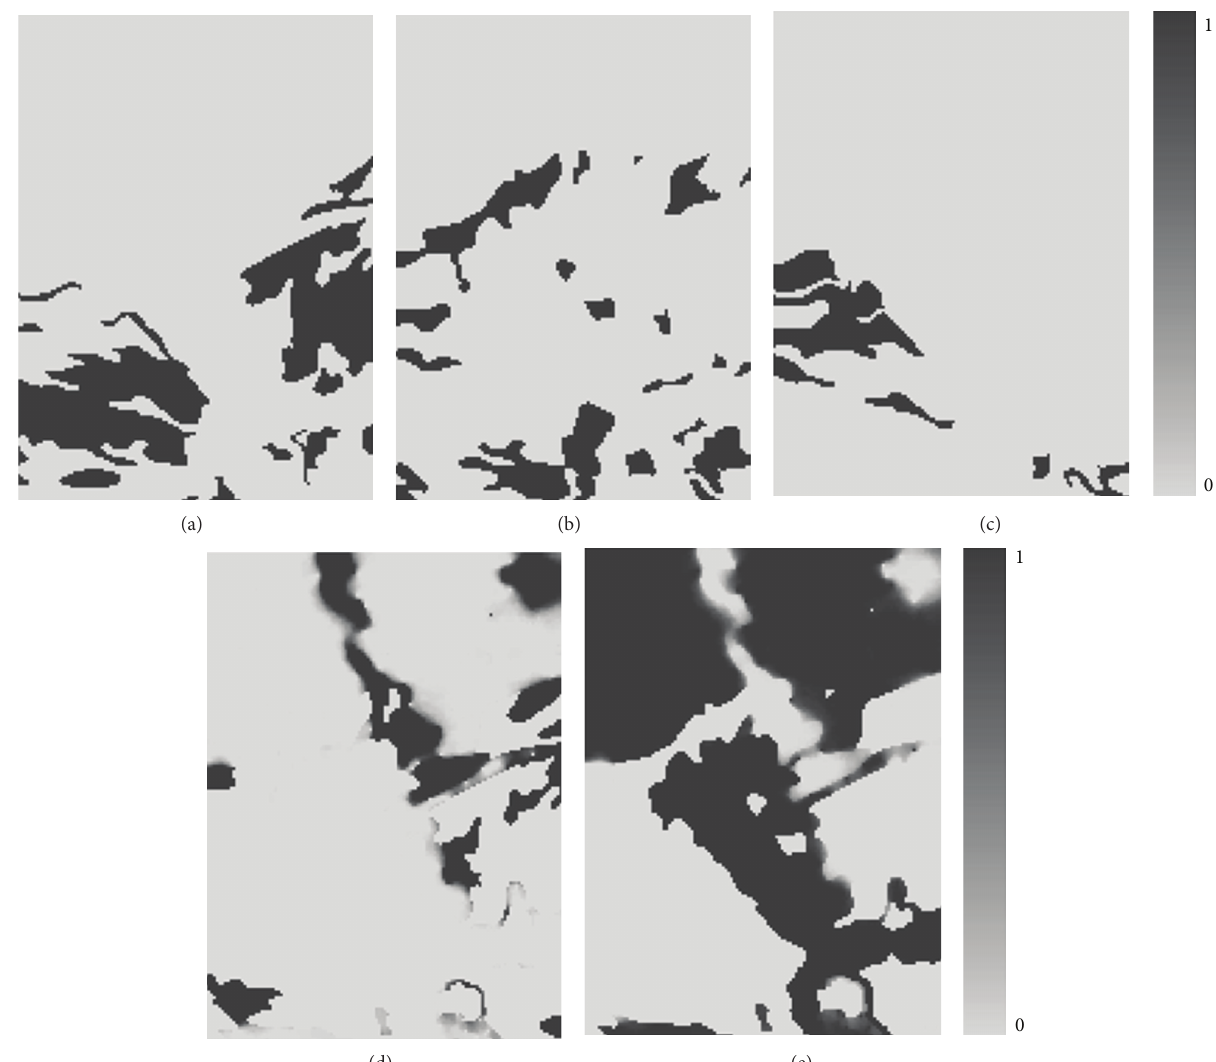
Figure 7: Occurrence probability maps of updated single soil series conditioned on the sample data and the legacy soil map using the Co- MCSS method. (a) SU2; (b) SU3; (c) SU4; (d) SU6; and (e)